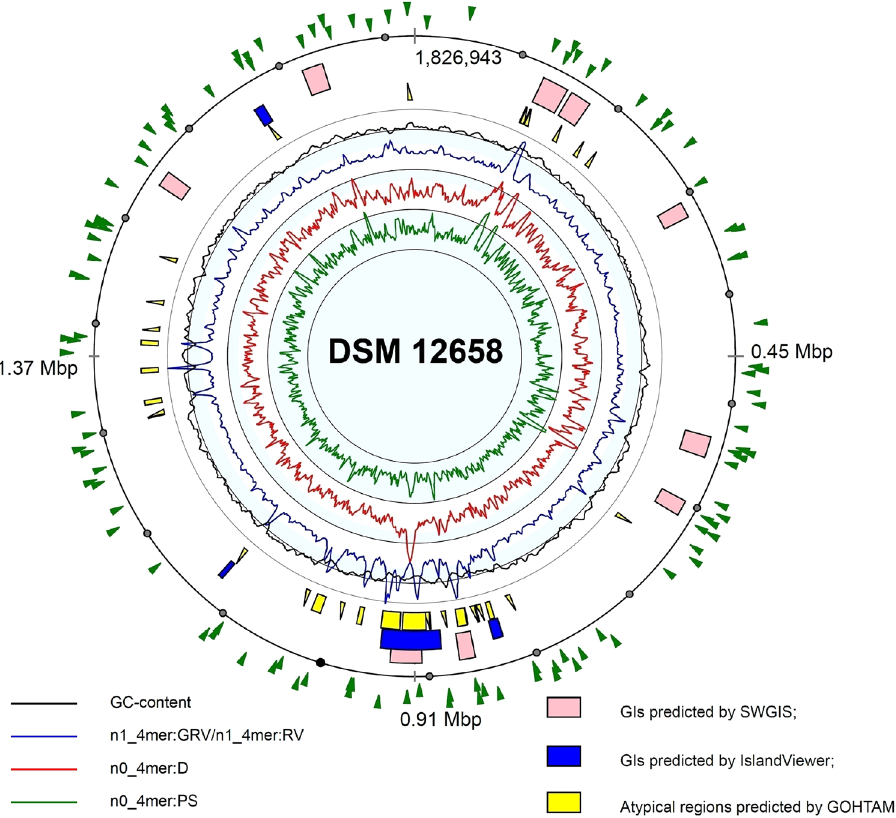
Figure 1. The genome and genomic islands (GI) of F. acidiphilum Y T . Localization of GIs on the chromosome of F. acidiphilum Y T , as predicted by SWGIS (pink boxes), IslandViewer (blue boxes) and GOTHAM (yellow boxes). Histograms in the inner cycles of the atlas depict variations of the following oligonucleotide usage parameters: GC-content (black curve); ratio of generalized to local relative variances calculated for tetranucleotide usage patterns normalized by the GC-content (blue curve, n1_4mer:GRV/n1_4mer:RV); distances between not-normalized local tetranucleotide usage pattern and the global one calculated for the complete chromosome (red curve, n0_4mer:D); asymmetry between not-normalized tetranucleotide usage patterns calculated for the direct and complement DNA strands (green curve, n0_4mer:PS). Use of these parameters for GI identification and their standard abbreviations were explained in more detail 68 . Green arrowheads (outer circle) indicate single-nucleotide substitutions in the genome of F. acidiphilum Y T after ~550 generations in the laboratory culture (s. Supplementary Table S2 for more